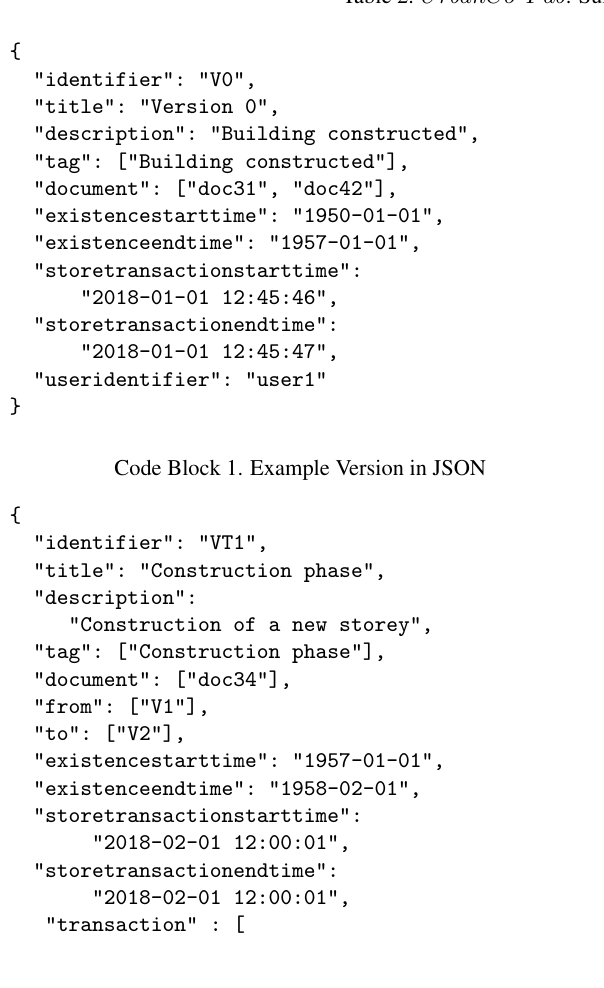
Table 2. UrbanCo 2 Fab : Summary of major